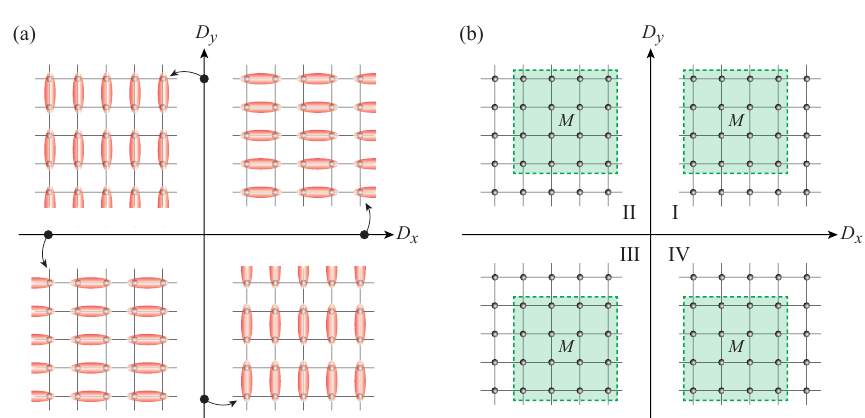
Figure 8: The choice of region M with “ even- (cid:101) B ” type bounary: (a) The four special patterns of VBS order in the plane of order parameter ( D M with even R (= 4 ) in each quadrant, whose boundary cuts least column of singlet bonds.